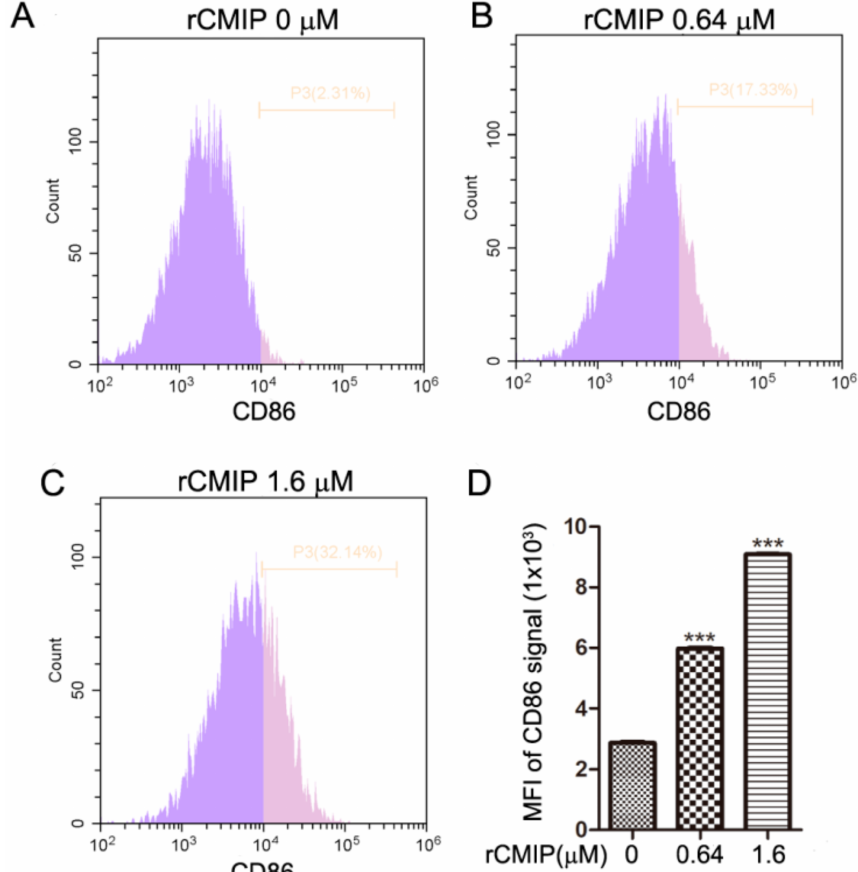
Figure 4. ( A – C ) rCMIP regulates the expression of CD86 in RAW 264.7 cells. RAW 264.7 cells were treated with 0.64 µ M and 1.6 µ M of rCMIP for 24 h. Cells treated with PBS acted as the control. The CD86 expression was detected by flow cytometry assay. ( D ) Histogram statistics of the data from the cytometry assay. Results are means ± SD ( n = 3). *** p <